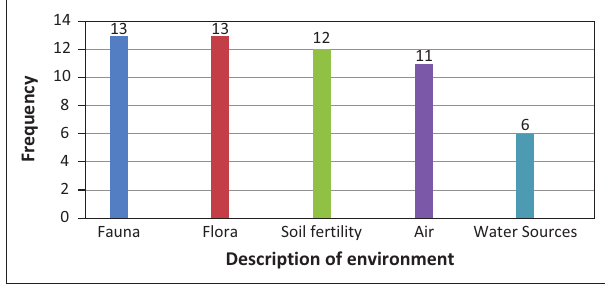
FIGURE 7: Type of natural environment mostly affected by veld